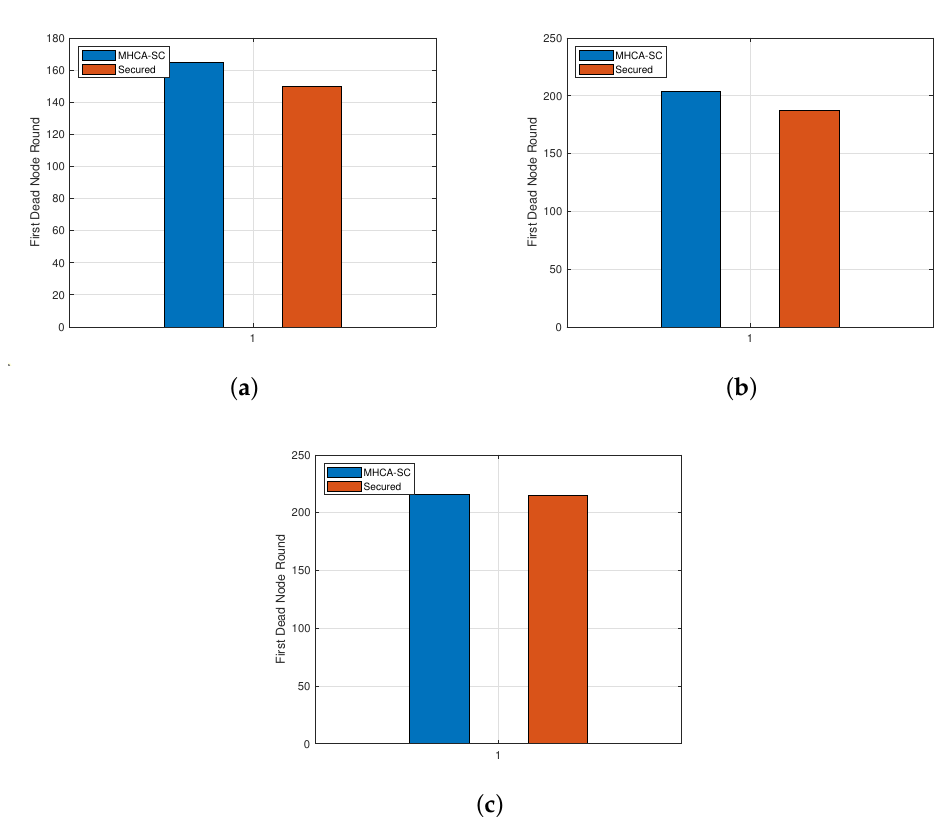
Figure 8. First dead node. ( a ) 300-node model. ( b ) 400-node model. ( c ) 500-node model.